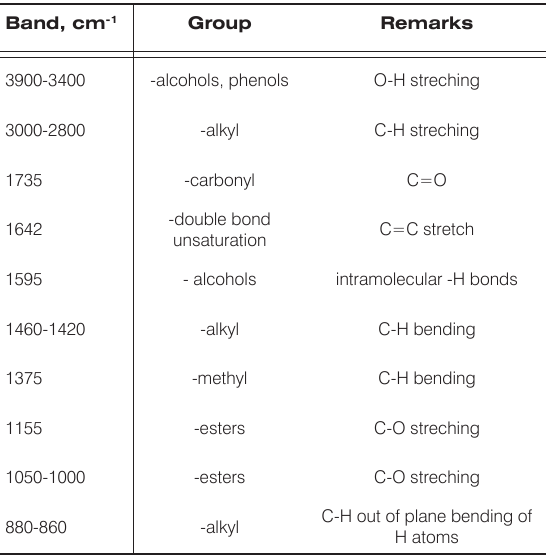
positions (cm -1 ) of FTIR-VAR bands and their suggested vibrational assignments for Baltic and Romanian amber in the 4000-600 cm -1